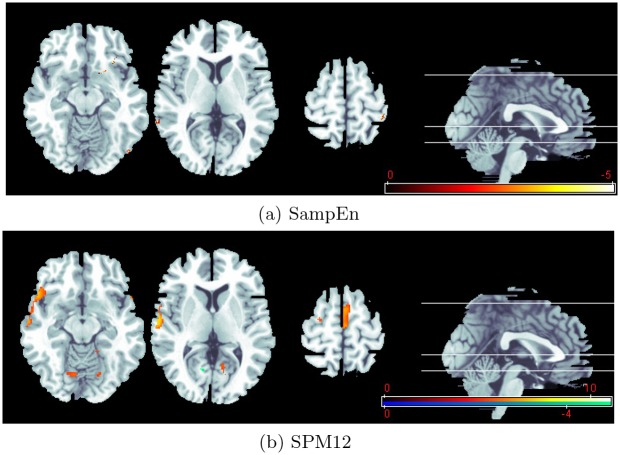
The activated clusters detected by (a) SampEn, in which statistical T+ map reveals an activation change in two experimental paradigms (neutral-blank to threat-neutral); (b) SPM12, in which statistical T map reveals activations during processing of neutral-blank (hot orange) and threat-neutral (winter blue).